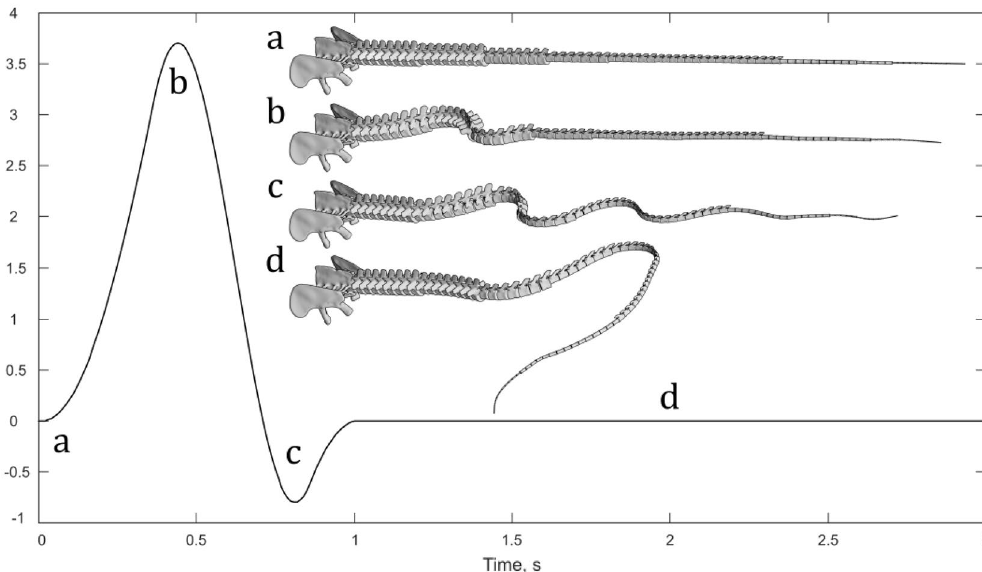
Figure 1. The degrees of rotation with respect to the X-axis imposed with the motion prescribed to the first eight vertebrae. ( a ) Position of the caudal centra at the beginning of the simulation. ( b ) Position of the caudal centra at the end of the first cosine input. ( c ) Position of the caudal centra at end of the second cosine input. ( d ) Position of the caudal centra at 2 s in the simulation, when the first eight centra are